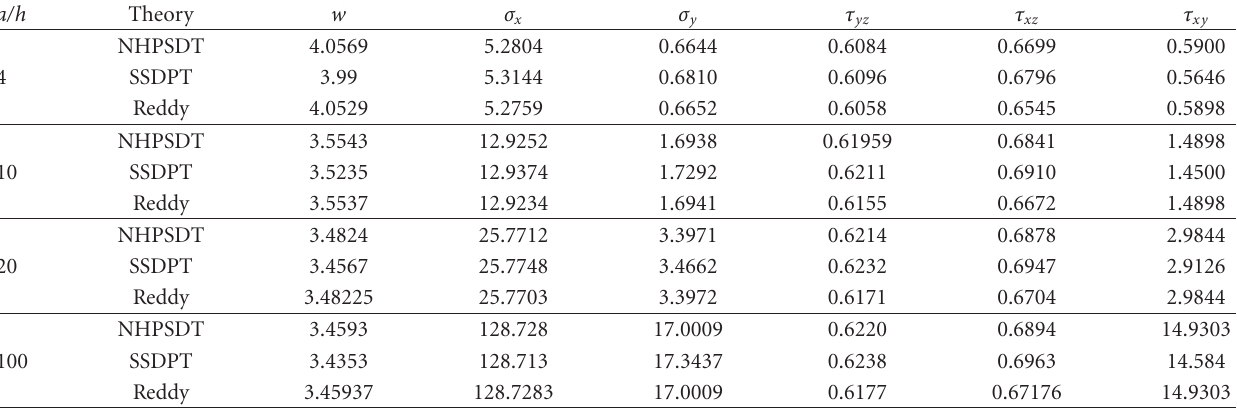
Table 6: Comparison of normalized displacements and stresses of a FGM rectangular plate ( b = 3 a ) and k = 2.